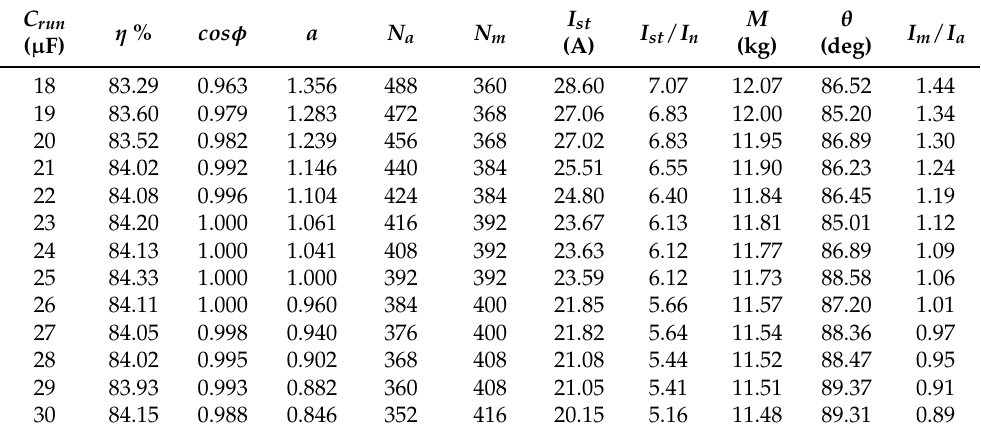
Design parameters and performance quantities of the SPIMs with rotor bars of quadrangular shape.